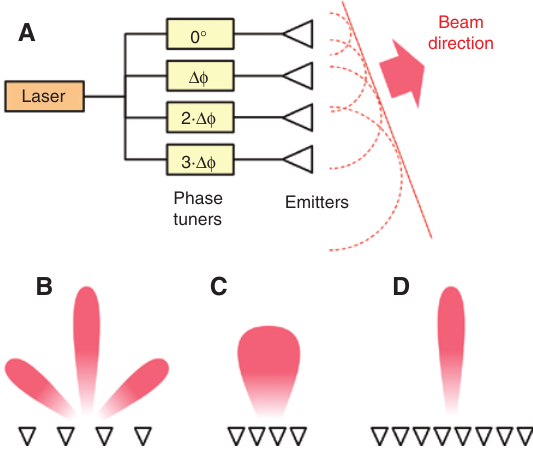
Figure 1: Operation principle of phased